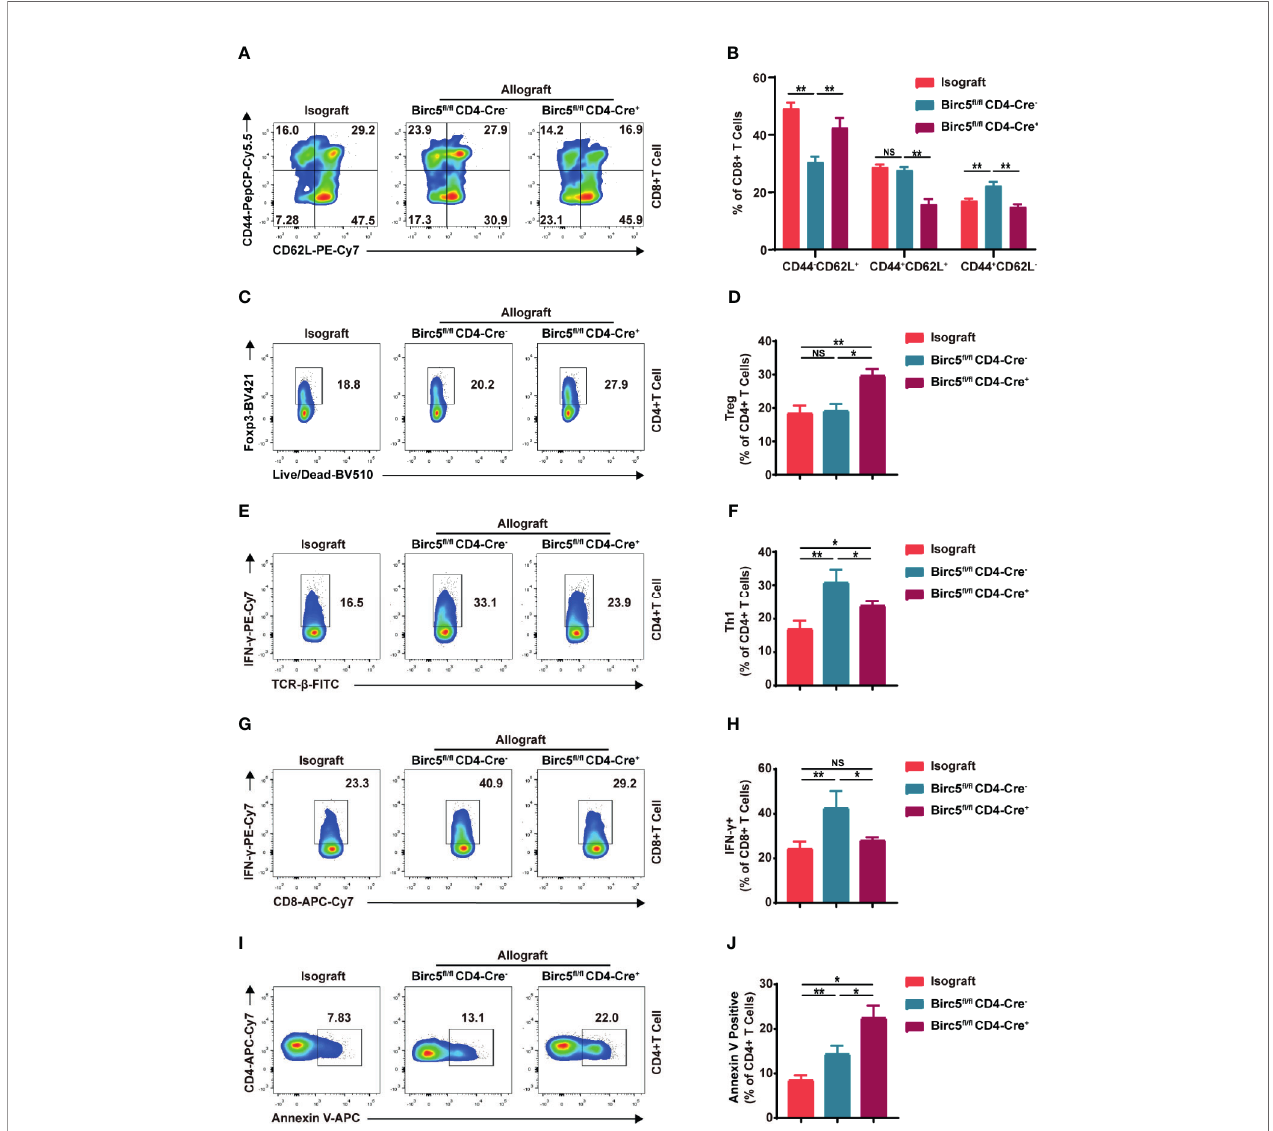
FIGURE 3 | Impact of Birc5 knockout on the subsets of T cells in the spleen after heart transplantation. (A) Representative fl ow plots of the expression of CD44 and CD62L on CD8 + T cells. (B) Bar graphs represent the percentages ± SD of each gated sub-population of naive (CD62L + CD44 – ), effector/effector memory (CD62L – CD44 + ) and central memory (CD62L + CD44 + ) T cells on CD8 + T cells from indicated groups. (C – H) Representative fl ow plots of (C) CD4 + Foxp3 + , (E) CD4 + IFN- g + and (G) CD8 + IFN- g + . (D, F, H) Percentage of the parent gated cells in mice in the isograft, allograft WT or Birc5 -/- groups. (I) Flow-cytometry plots and (J) summary graph of Annexin V + live/dead - (early apoptosis) T cells isolated from the spleen of WT or Birc5 -/- mice at 6-8 weeks of age. Flow cytometry analysis of cytokine production by CD4 + and CD8 + T cells after re-stimulation with PMA and ionomycin in the presence of Golgi-Stop. Data are representative of 3 independent experiments (n = 5 mice per group). Bars represent mean ± SD, * p < 0.05, ** p < 0.01, ns, not statistically signi fi cant. See also Supplemental Figure 3